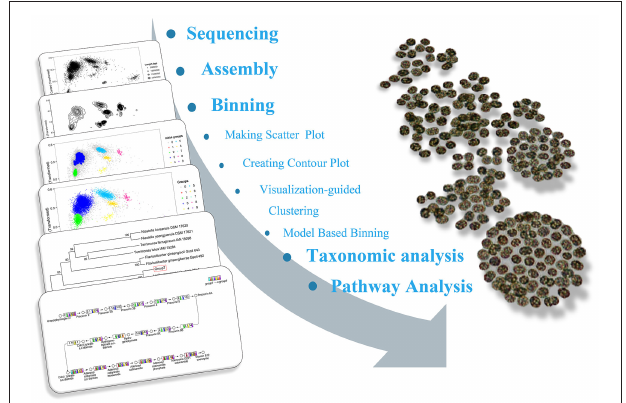
FIGURE 1 | Overview of the pipeline to bin genomes of each group from the Microcystis -dominated bloom metagenome. The screenshots in the left part of the figure correspond to the steps for analysis the datasets. Following the process, the association between Microcystis and attached heterobacteria on the metabolic level can be elucidated